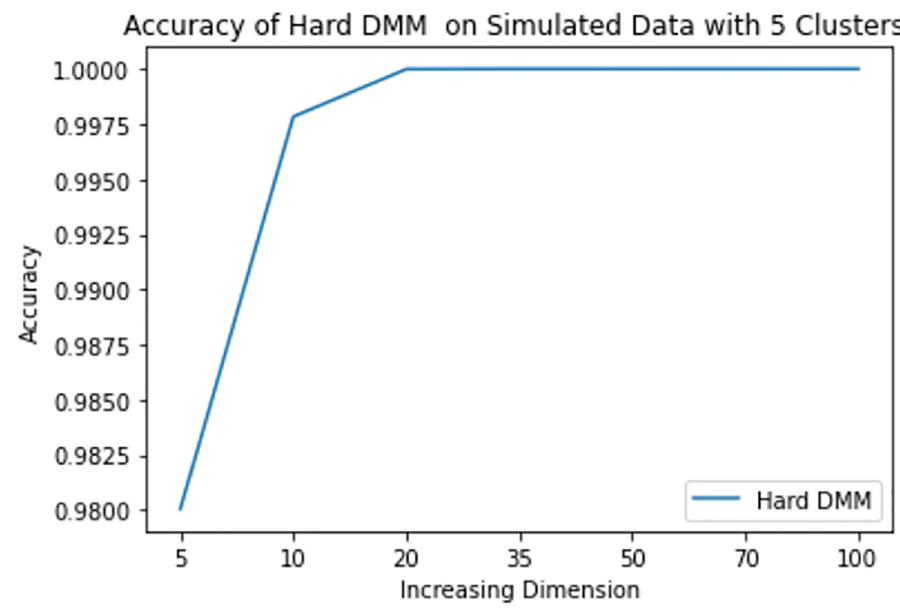
Fig 12. Mean accuracy of hard DMM 1 with 5 clusters and varied